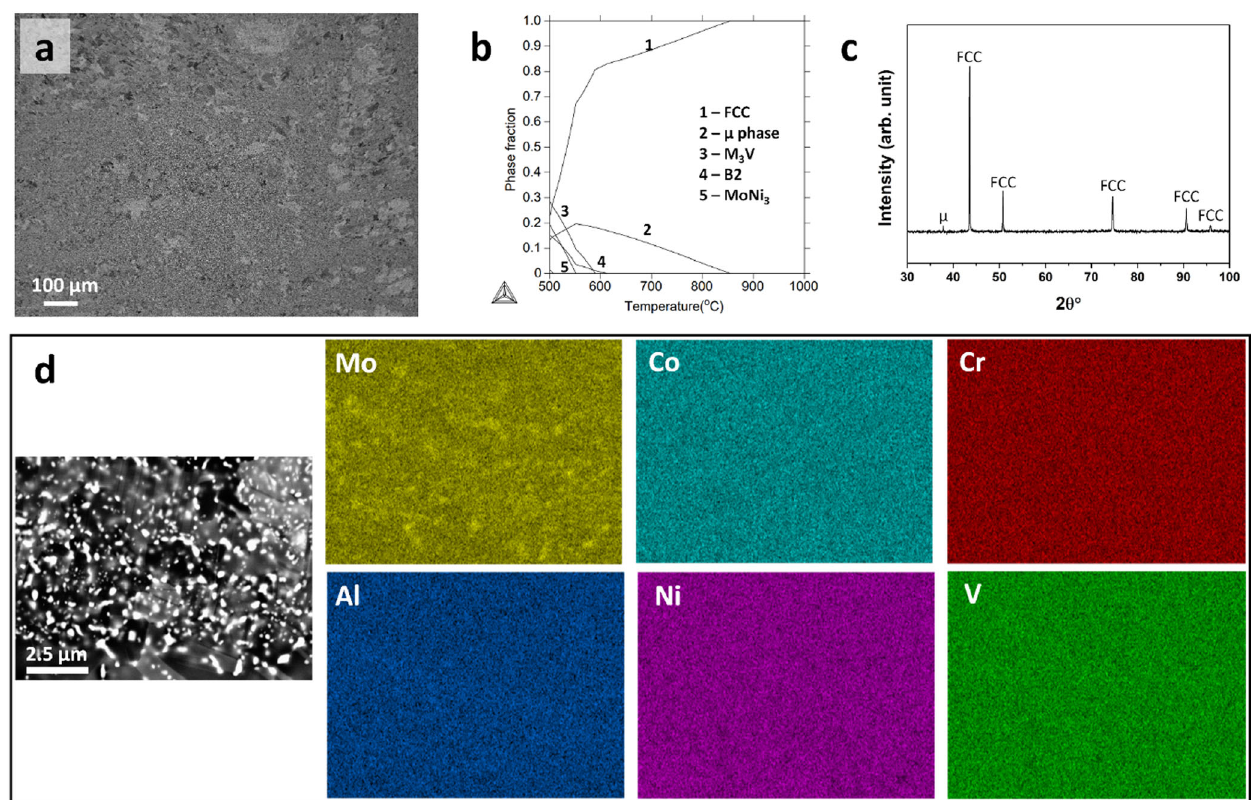
Fig. 4 Microstructure analysis of HEA1. a BSE-SEM image. b Mole fractions of equilibrium phases at various temperatures. c XRD pattern. d BSE image and corresponding EDS